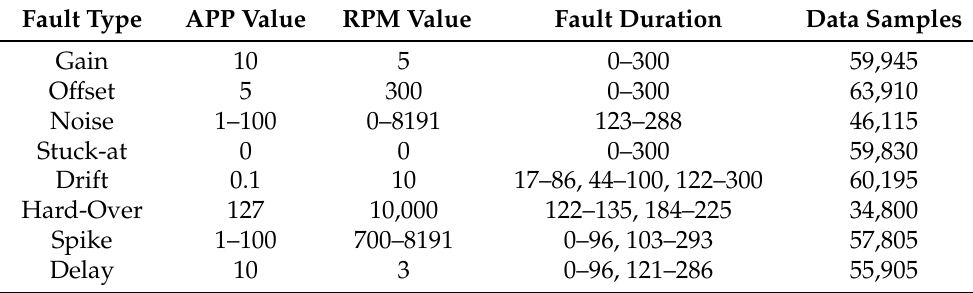
Table 4. Configuration of fault injection with collected data samples.